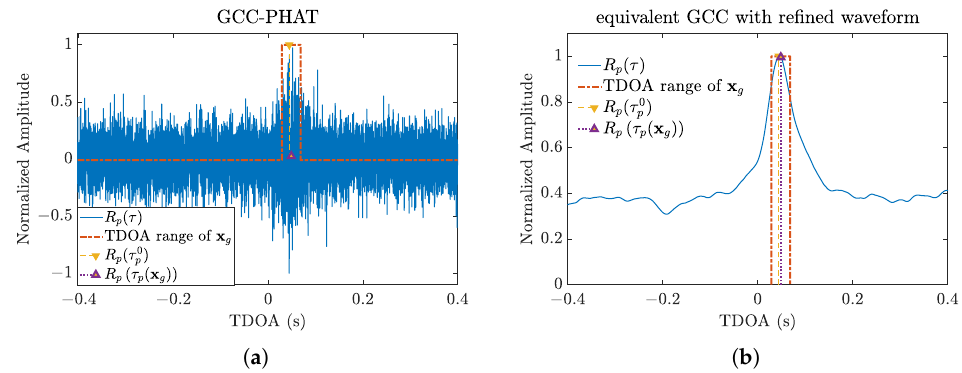
Figure 4. An example of refined GCC from field data: ( a ) GCC-Phase Transform (PHAT); ( b ) re- fined GCC.